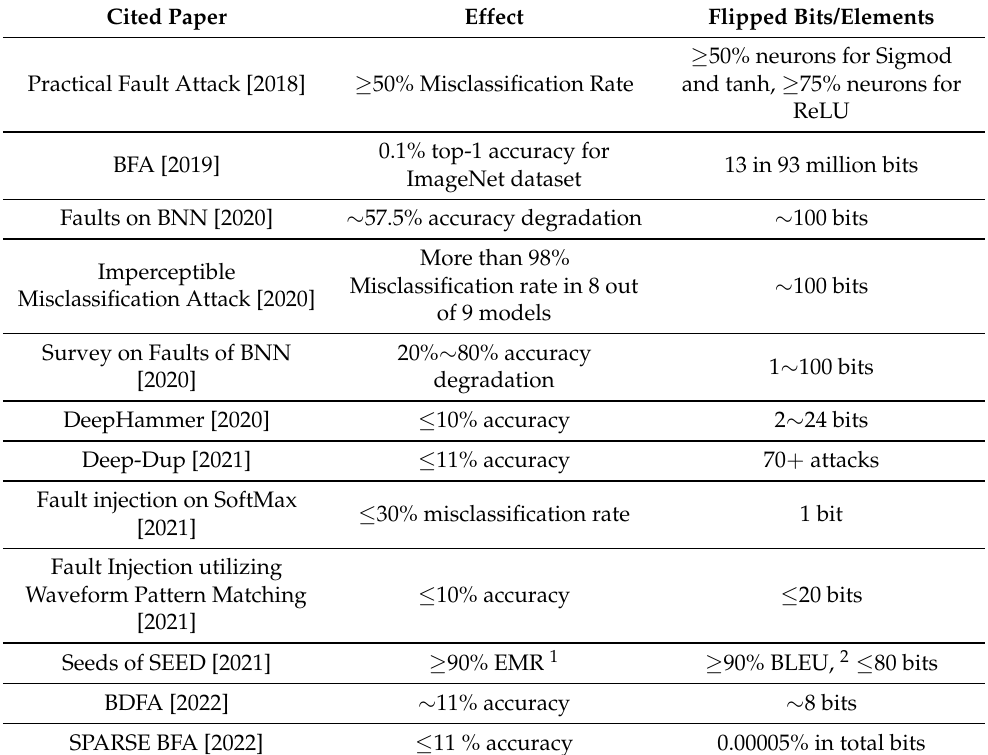
Table 5. The results of untargeted attack-related